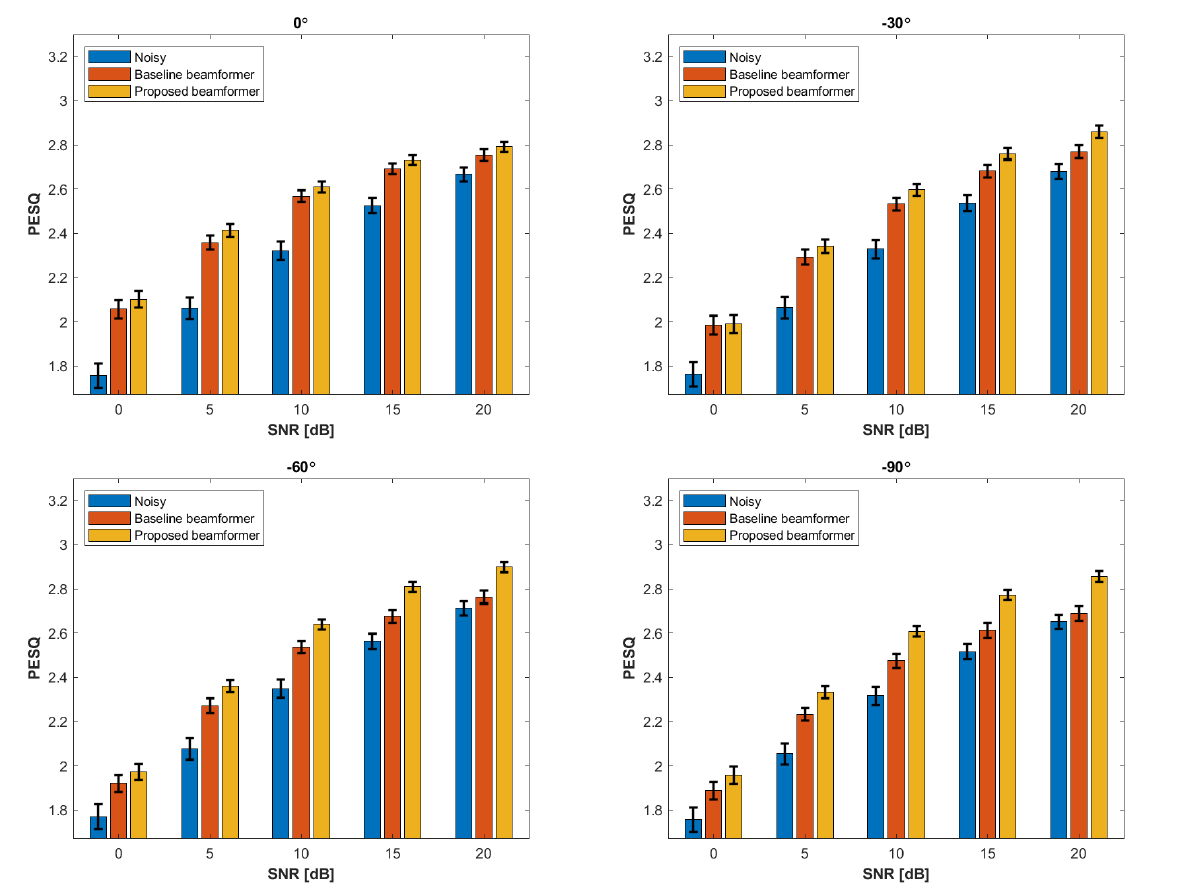
Figure 5. Average PESQ scores and 95% confidence intervals for noisy input and the outputs of the baseline and the proposed beamformers depending on the azimuth of the desired source in diffuse noise environments with the reverberation time (RT60) of 500